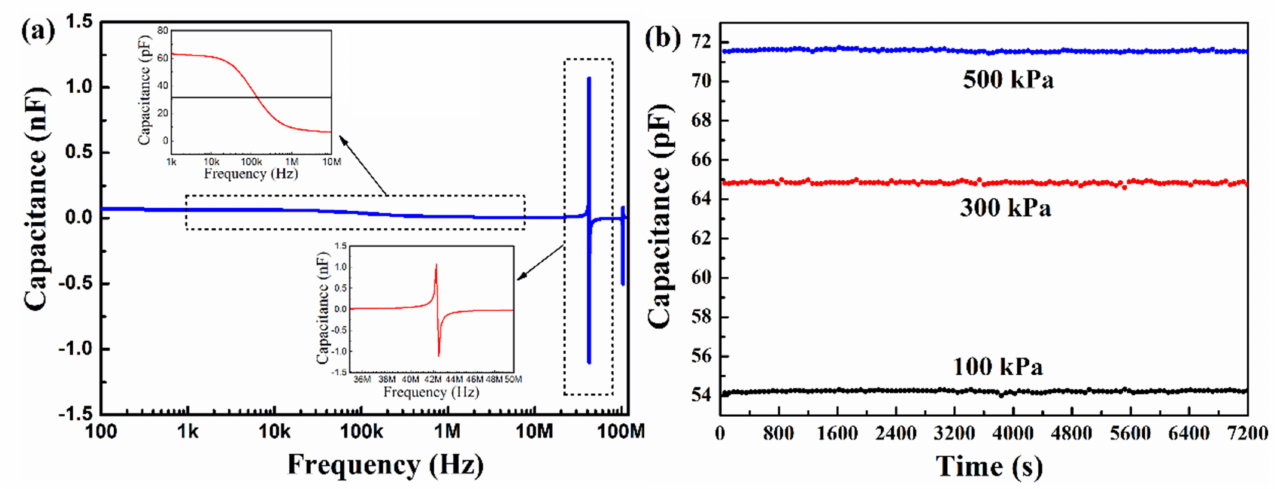
Figure 7. ( a ) C-F and ( b ) C-T characteristics of CPSs with diaphragm radius in 2000 µ m at the ambient temperature of 25 ◦